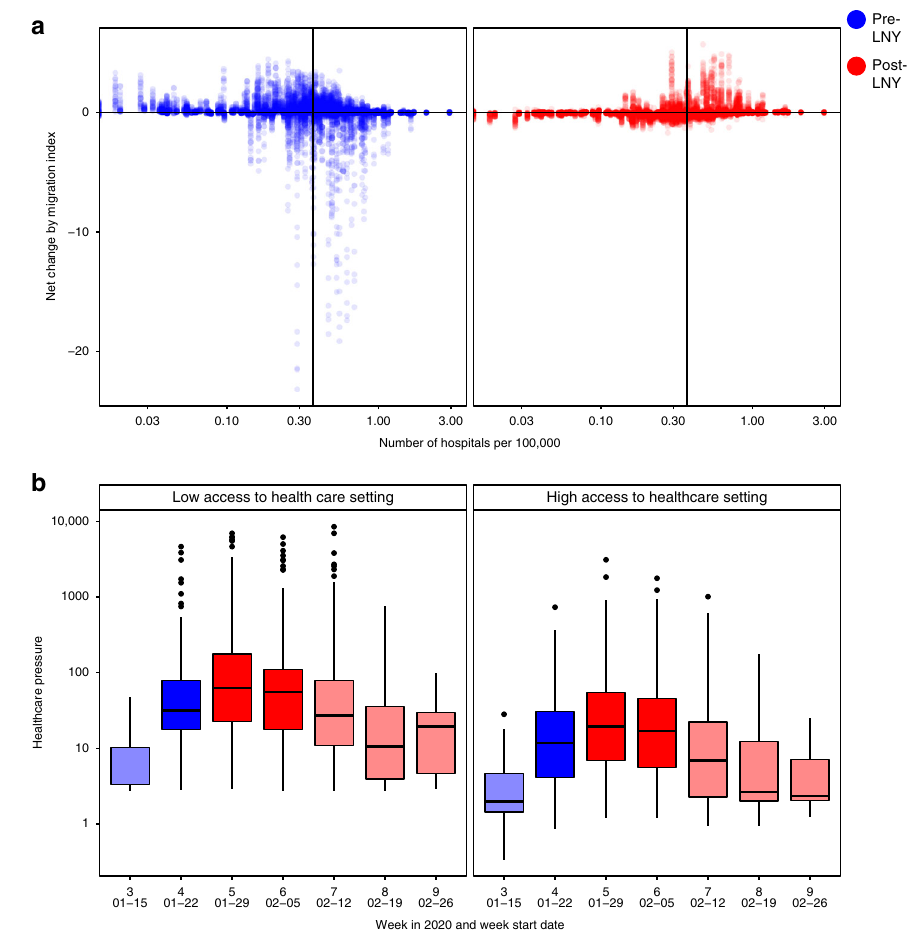
Fig. 3 Healthcare service availability and COVID-19-related healthcare pressure. a The changes in traveller volume before (blue) and after (red) LNY. Net change is de fi ned as inbound migration index minus outbound migration index. Thus, a negative change indicates more travellers leave than arrive while a positive value indicates more travellers arrive than leave. A solid line indicates the median level of healthcare capacity. b The changes in the healthcare pressure (log 10 scale) related to COVID-19 each week in low and high healthcare capacity prefectures. Healthcare capacity is measured by the number of hospitals per 100,000 residents ( n low = 157, n high = 153). Healthcare pressure is measured by con fi rmed COVID-19 cases divided by healthcare capacity. Darker shade represents weeks when low healthcare capacity settings experienced signi fi cantly higher pressure than high healthcare capacity settings; lighter shade represents when differences are not statistically signi fi cant based on Mann – Whitney U test (5% type I error rate). The comparison for week 7 has p-value = 0.06. The boxplots in panel b display Median, IQR and whiskers + / − 1.5 times